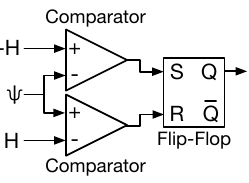
Figure 11. Switching circuit implementing the control law in